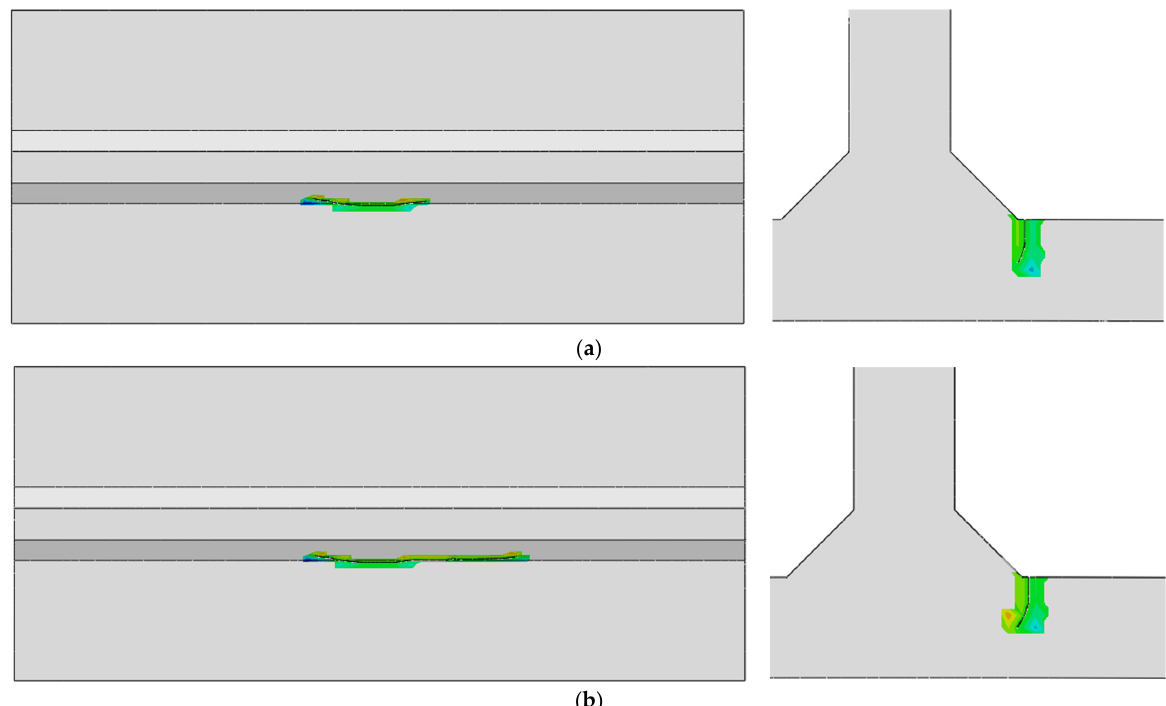
Figure 15. Crack propagation under a maximum displacement load of 0.3 mm: ( a ) without residual stress field at 100,000 cycles; ( b ) with residual stress field at 100,000 cycles.